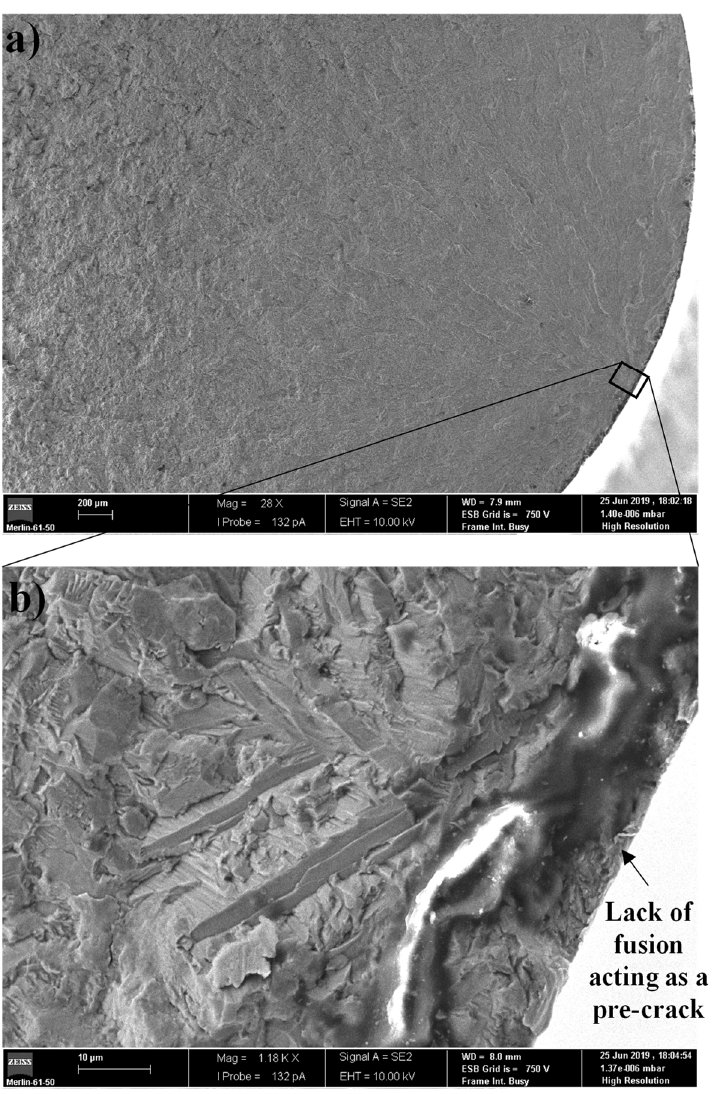
Figure 7. Fracture surface of solid specimen, σ a = 350 MPa. ( a ) Fracture surface; ( b ) Crack initiation site.